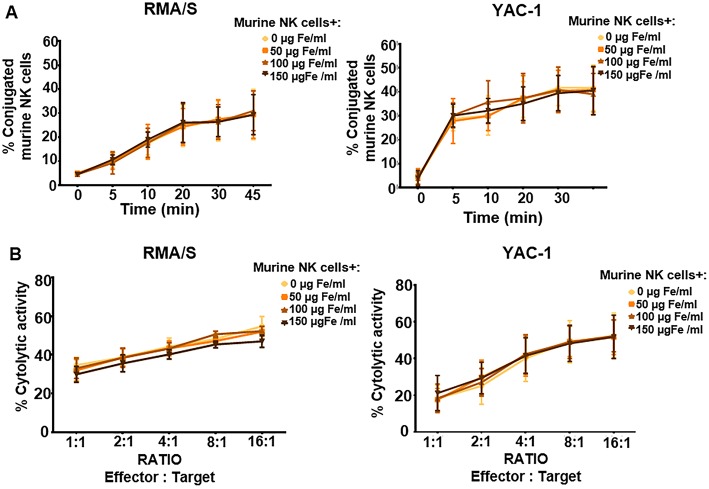
Functional assessment of murine NK cells after their association with MNPs. (A) Conjugation kinetics of NK-92MI cells after being treated with MNPs, with RMA/S (left panel) and YAC-1 (right panel) cell lines co-incubated in a 1:2 ratio. (B) Cytolytic activity of murine NK cells, after being treated with different concentrations of MNPs, against RMA/S (left panel) and YAC-1 (right panel) cell lines co-incubated at different ratios for 4 h. The data (mean ± SD) are representative of three or four independent experiments.